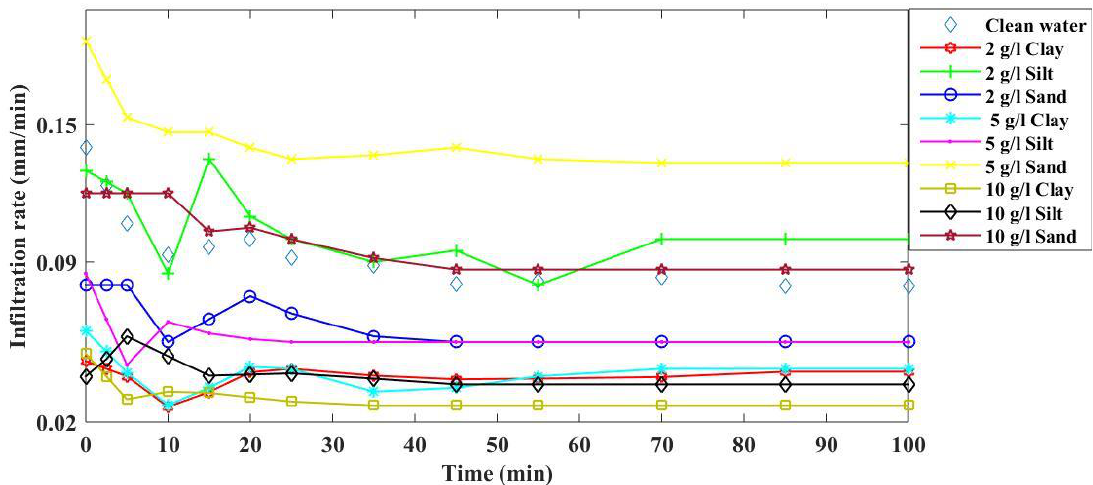
Figure 2. Infiltration rate plotted under different suspended solid sizes and concentrations.